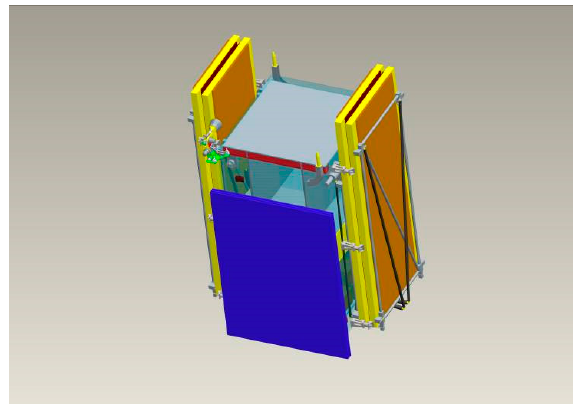
Figure 2. SAR antenna in stowed configuration.